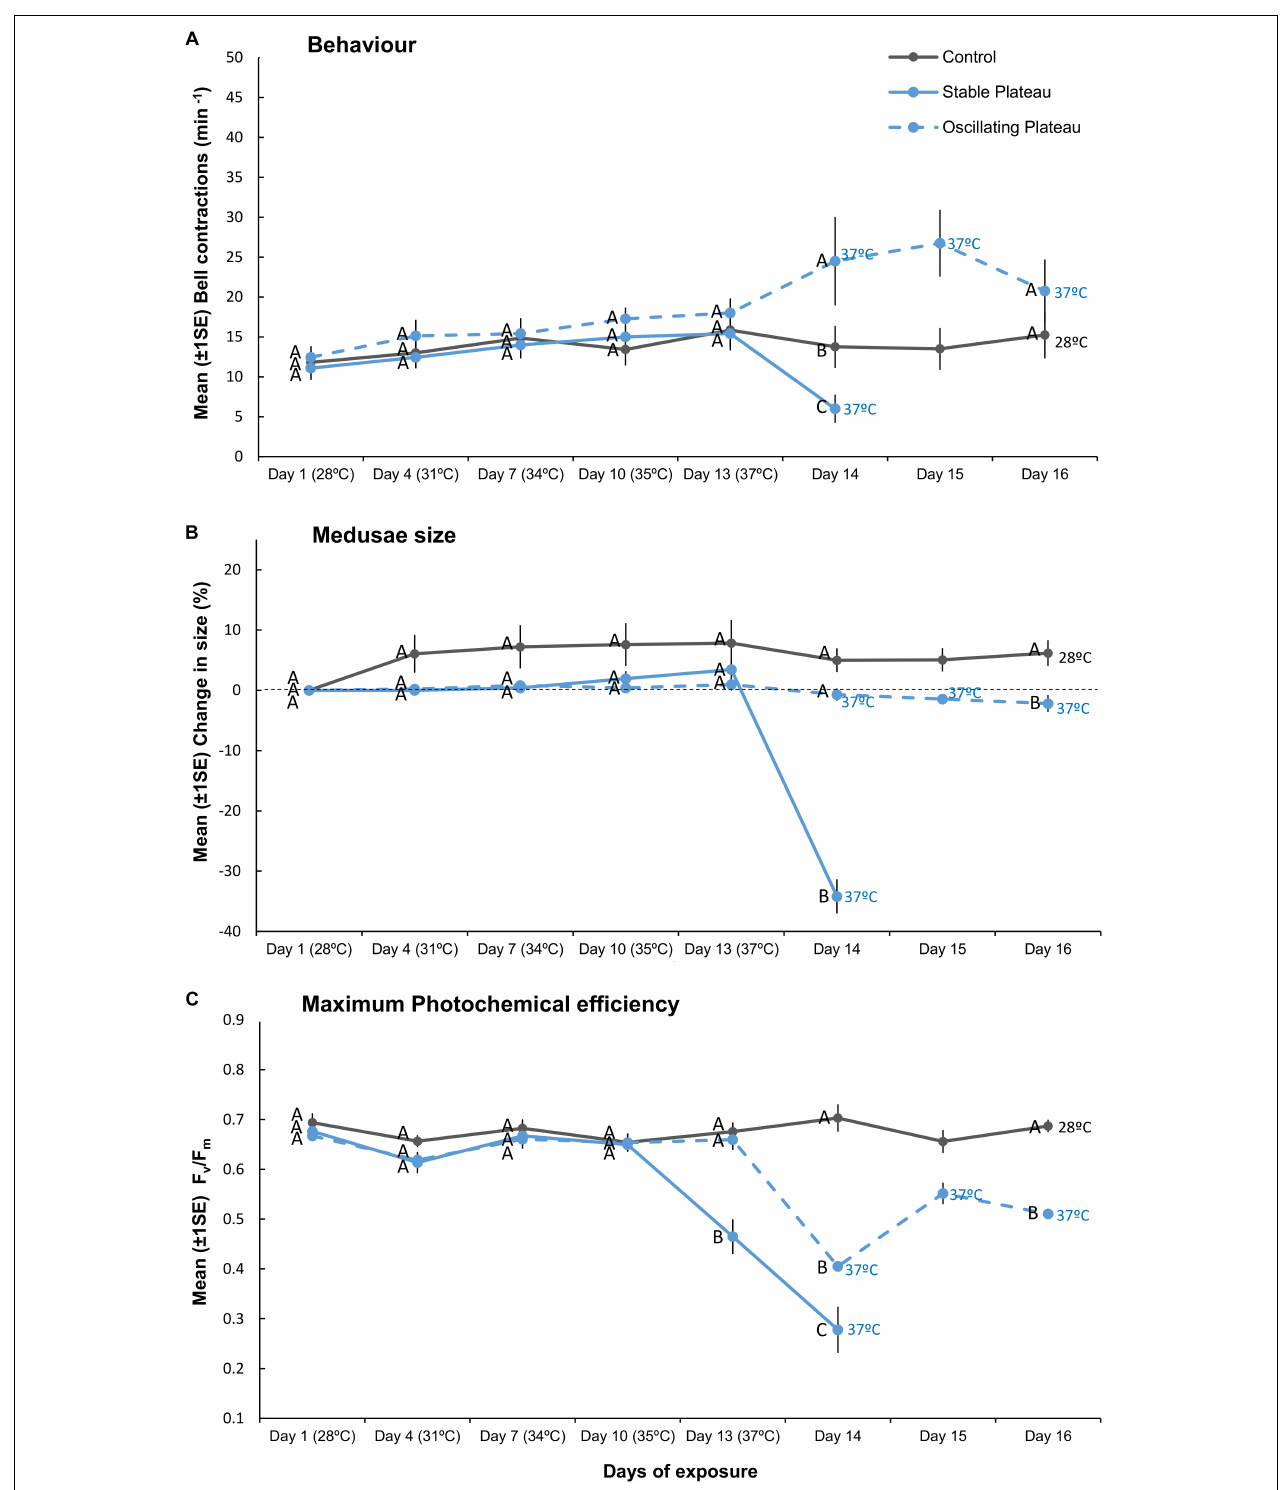
FIGURE 2 | Mean ( ± 1SE) (A) bell contractions (number min − 1 ), (B) change in size of medusae (%), and (C) maximum photochemical efficiency (F v /F m ), recorded throughout the 16-day exposure period for each treatment (S Plat , O Plat , and Control) employed in “Plateau” experiment (Part II). Letters next to data points indicate similarities (e.g., AA) or differences (e.g., AB) between the three treatments at each time point, as determined by estimated marginal means post hoc analyses, resulting from analyses reported in Supplementary Tables S2 , S3 . Note; sample sizes vary through time [Day 1 ( n = 11), Days 4–13 ( n = 7), Day 14 ( n = 4), Days 15–16 ( n = 3–4) ( n represents number of replicates per